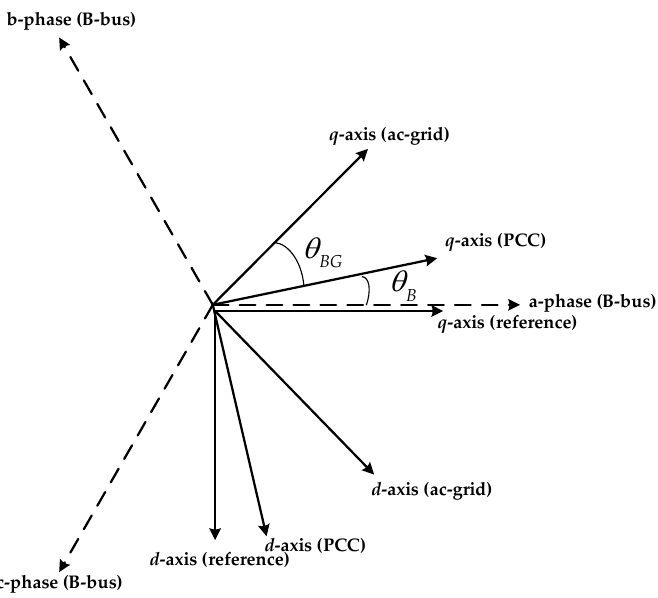
Figure 2. The PLL synchronization process.